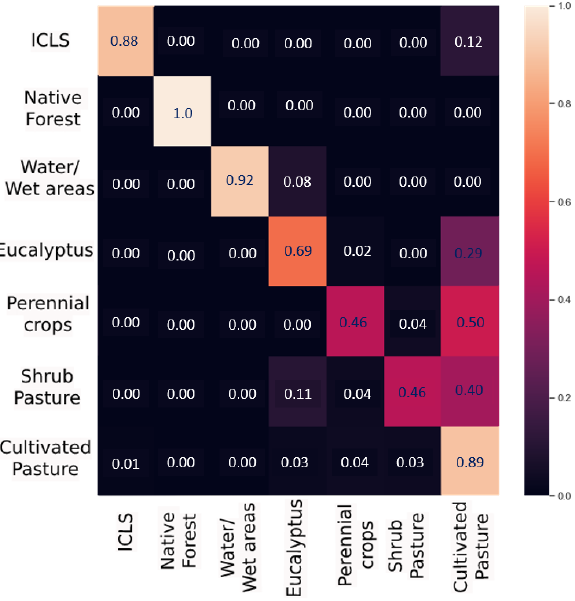
Table 3. Entries with the highest feature importance in three different time windows.